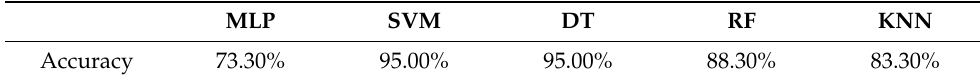
Table 6. Classification results for Dataset 03 (lung cancer/control).